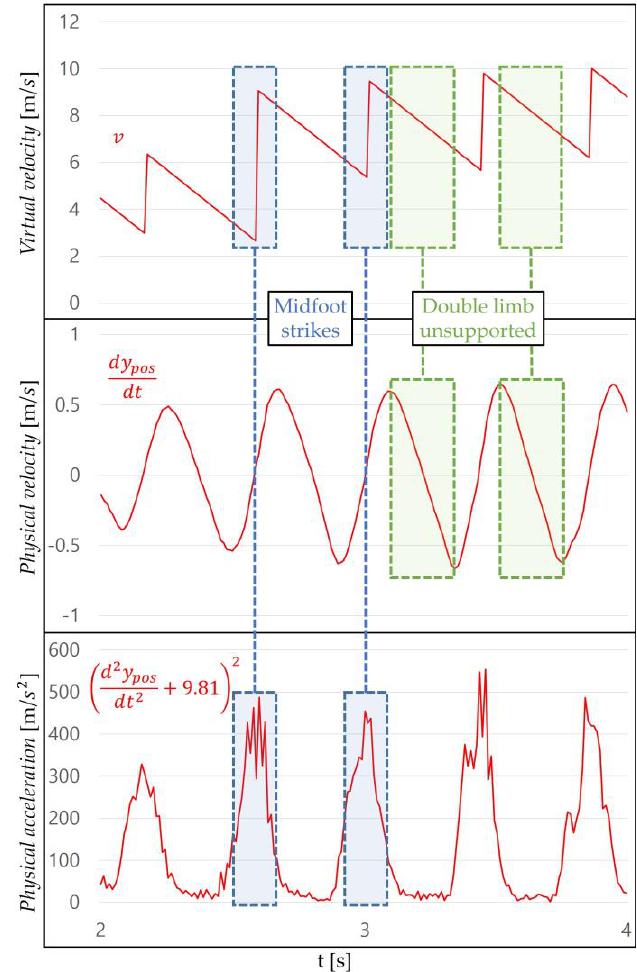
Figure 10. This shows the virtual velocity when using WIP: v (m/s). This is the result when 𝑣 0 ∈ [4, 12] , a = 9 m/s 2 . If a step is detected, v is updated to new 𝑣 0 .